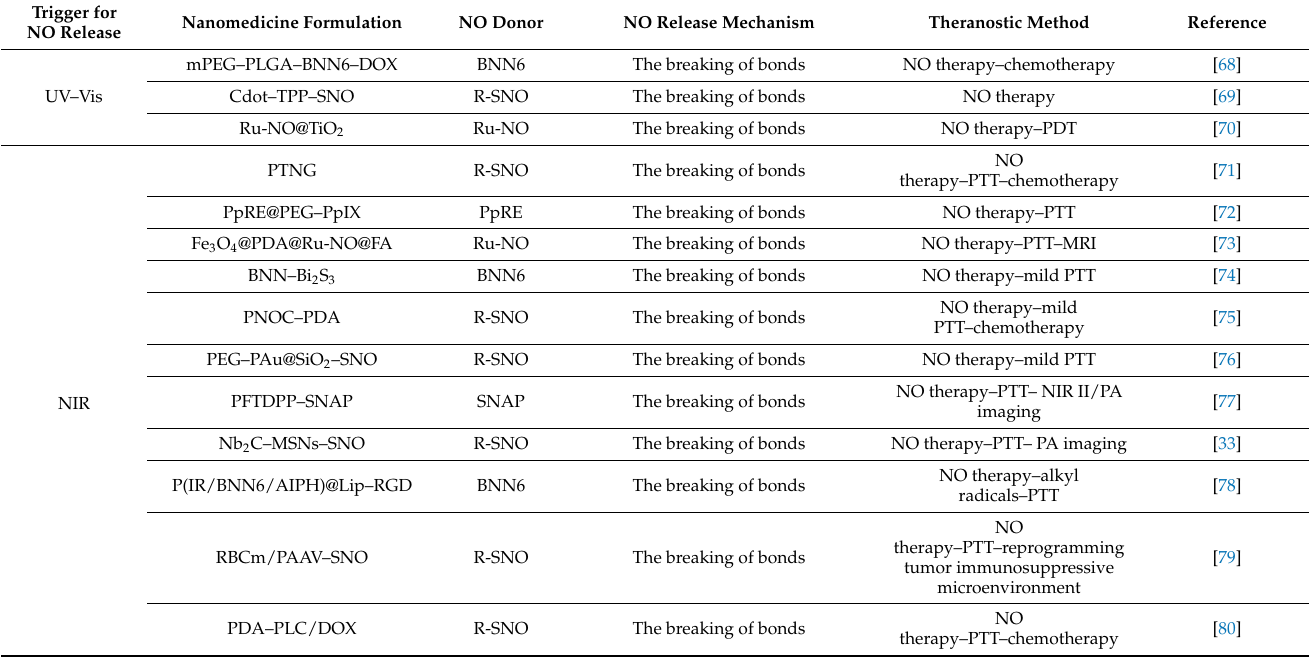
Table 1. Summary of the release mechanism and theranostic method of stimulus-responsive NO-based nanomedicine. Trigger for NO Release Nanomedicine